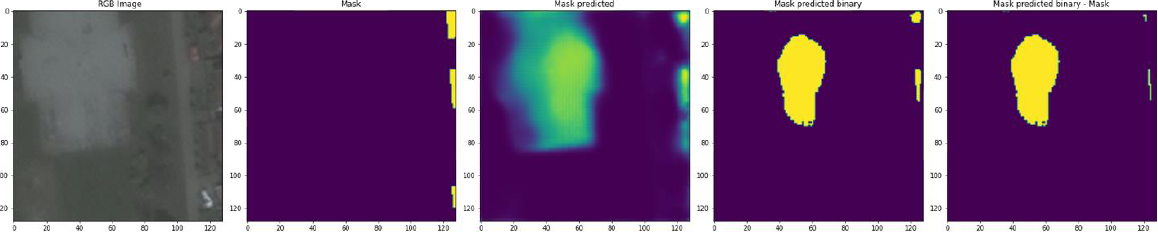
Figure 19. Concrete terrain identified as a building.